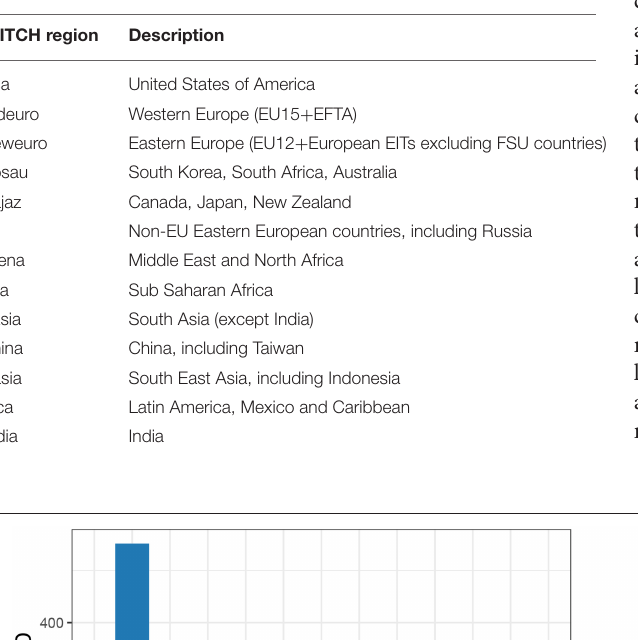
TABLE 2 | Regions of the WITCH model.